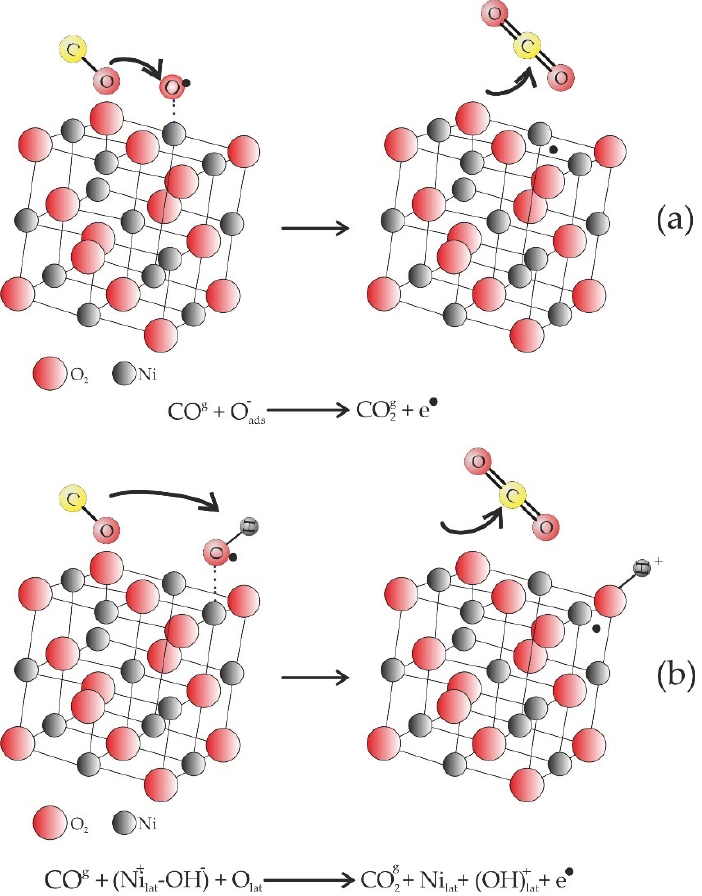
Figure 9. The associated cartoon describing the gas sensing mechanisms of both NiO1- and NiO2-based gas sensors when interacting CO with pre-adsorbed oxygen ( a ) and with surface hydroxyl groups ( b ).